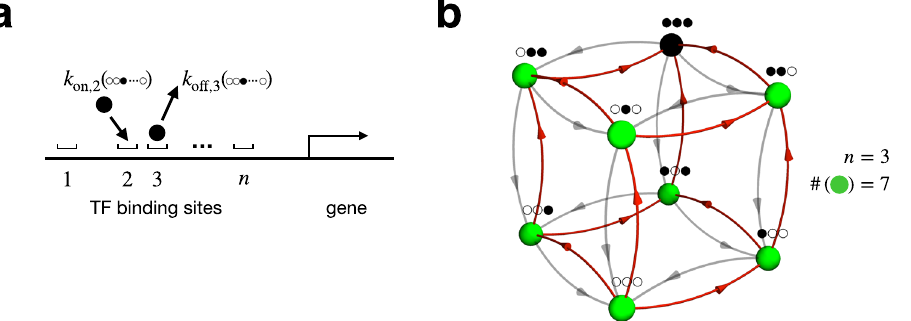
Fig. 3 | Unordered binding. a A gene may be regulated by the binding of tran- scription factors (TFs) to some number n of sites. The most general case is that of unordered binding to distinguishable sites. The TFs might bind in any order, and